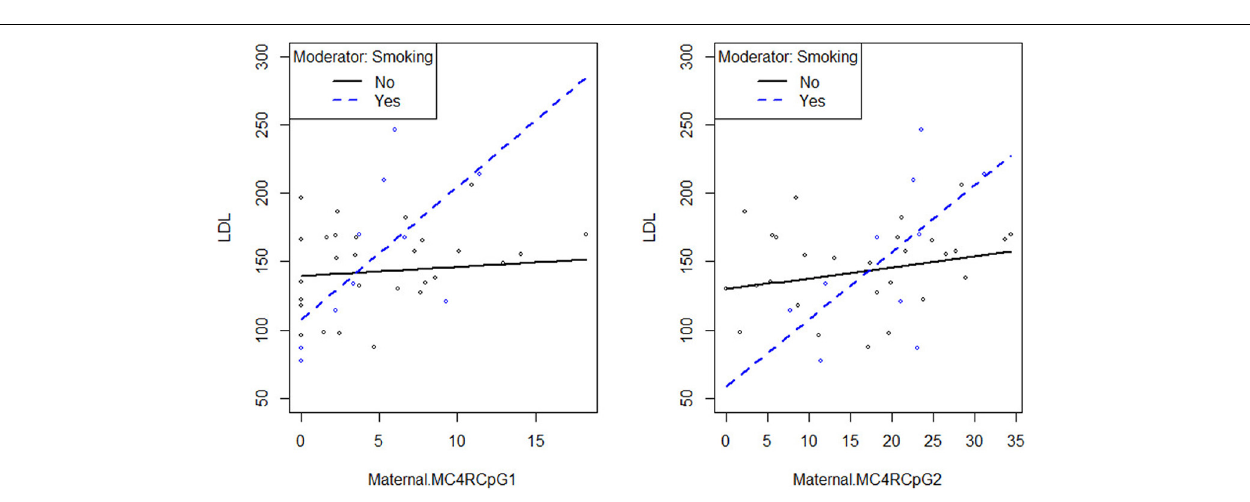
FIGURE 4 | Smoking habit moderates the relation between MC4R DNA methylation at CpG1 on the maternal side and LDL at the third trimester of pregnancy ( β smoking = yes ∗ CpG1 DNA methylation = 9.08, p =